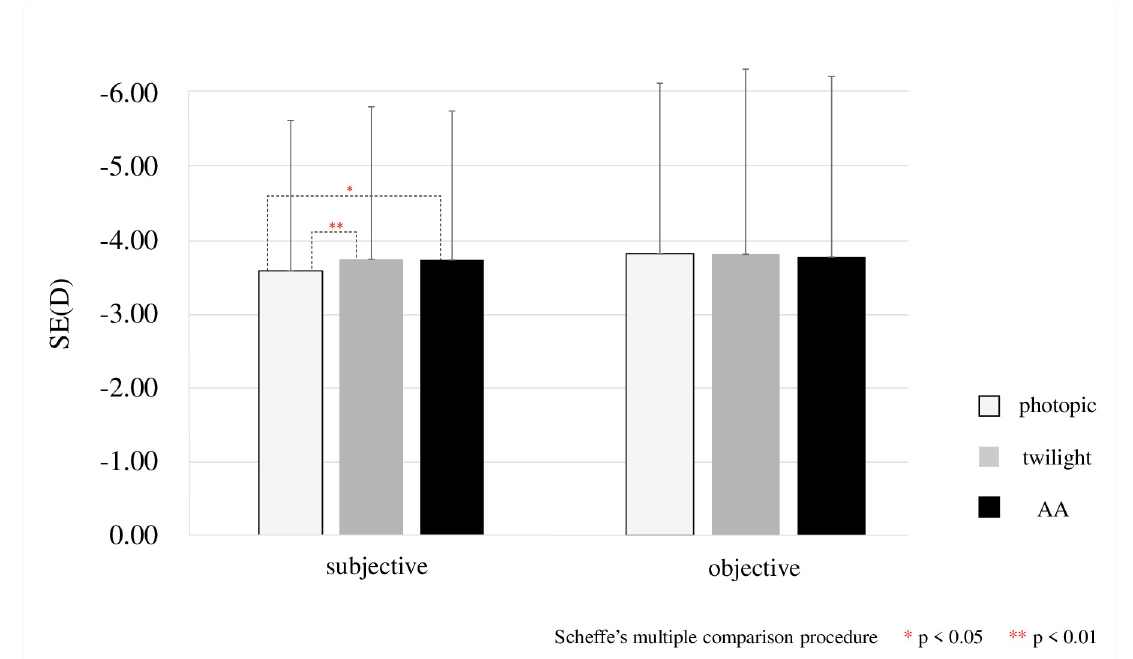
Fig 5. Results of subjective and objective SE in photopic and twilight and AA are shown. When the results of these three conditions are analyzed using the Friedman test, only subjective SE shows a difference between the conditions, p = 0.003. Therefore, when Scheffe’s multiple comparison procedure is performed, there is a significant difference in subjective SE, p = 0.007, between photopic and twilight conditions, and p = 0.023 between photopic and AA.